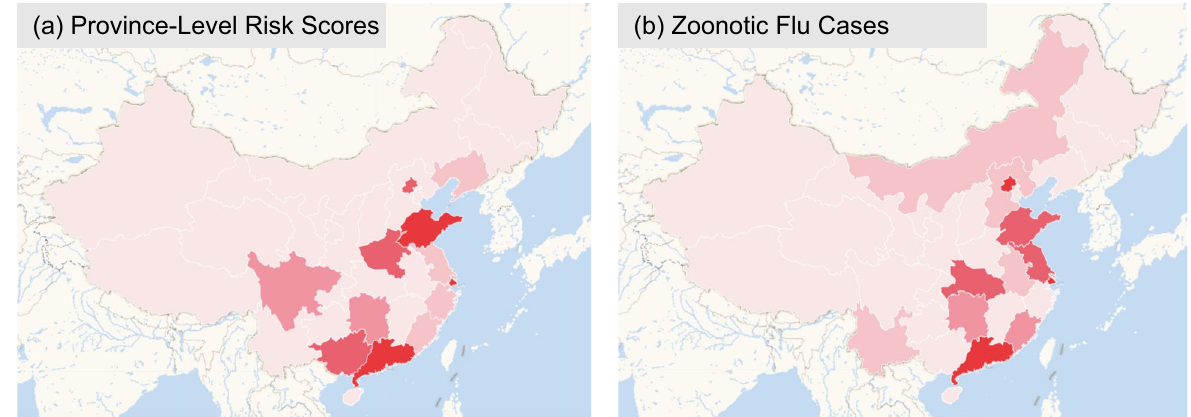
Figure 4. Association of risk scores and zoonotic disease by province. The province-level risk scores are shown in ( a ) and the number of zoonotic flu isolates (cases) in humans per province is shown in ( b ). In both maps, darker (lighter) red indicates a higher (lower) value of risk scores and zoonotic flu isolates in humans. The correlation between these variables is 0.701, implying that the province-level risk scores explain nearly 50% of the variation in the number of zoonotic flu isolates in humans (interpreting the coefficient of determination). This map was created by the software provided by Dituhui: https:// www. dituh ui.